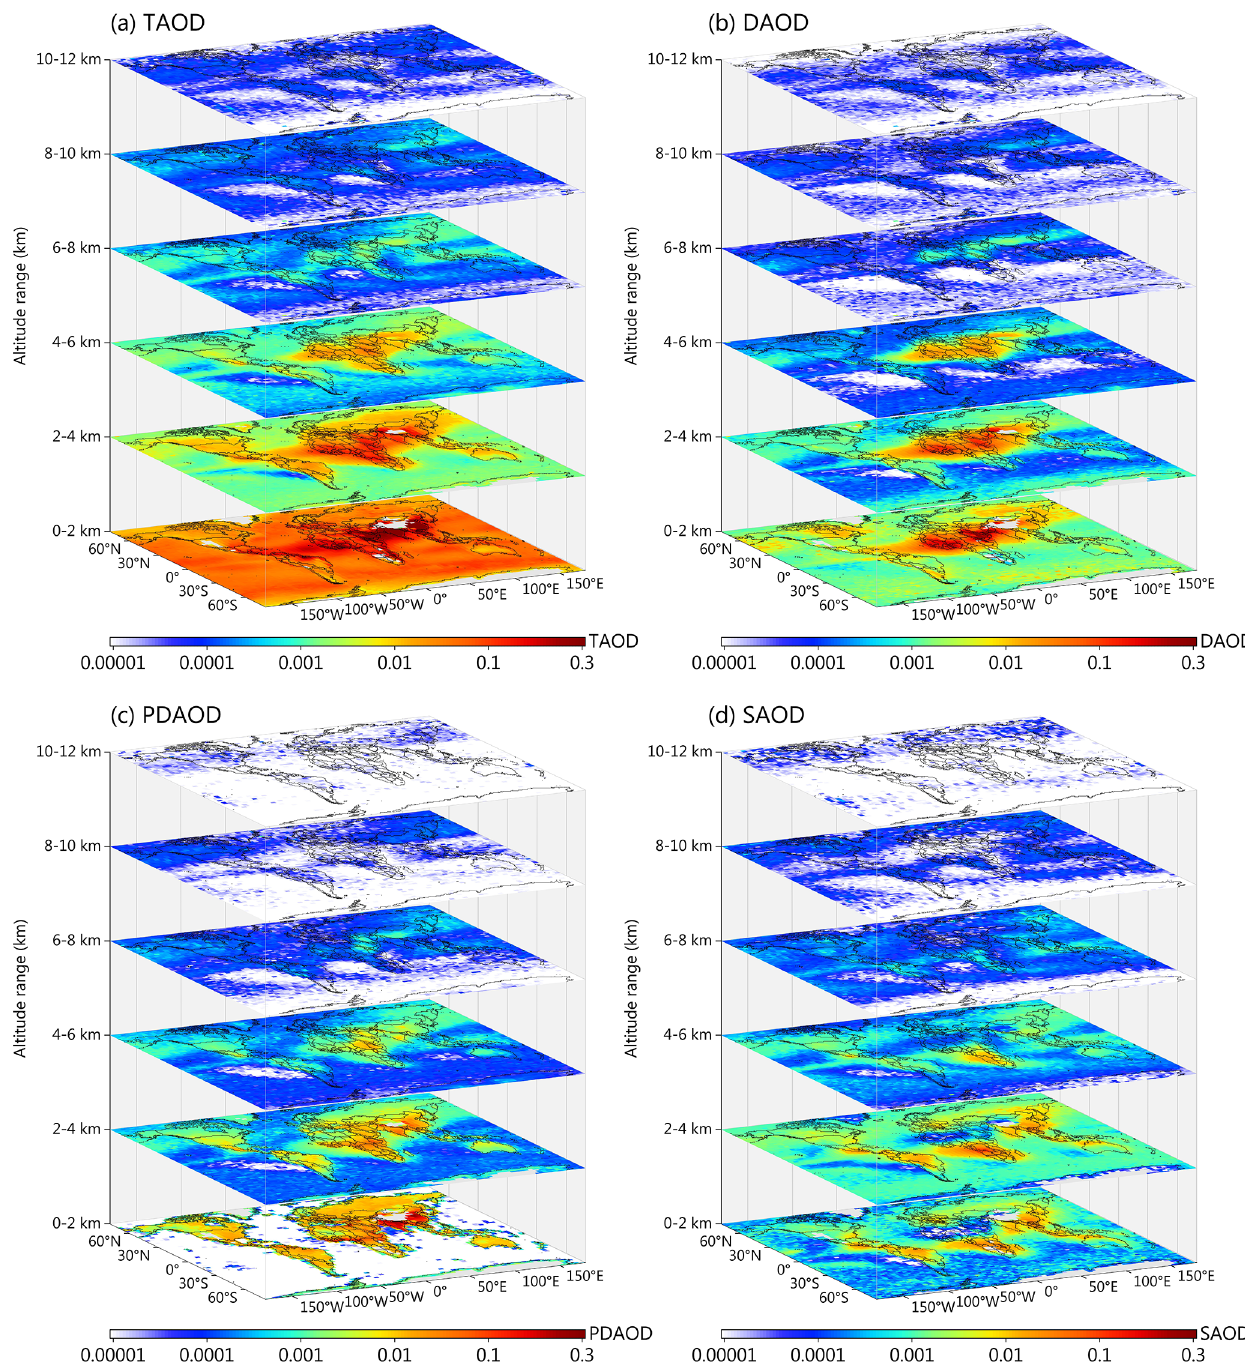
Figure 3. Spatial distributions of multi-year averaged layer-specific (integrated at 2km intervals from the surface to 12km) (a) total AOD (TAOD), (b) dust AOD (DAOD), (c) PD AOD (PDAOD), and (d) smoke AOD (SAOD).